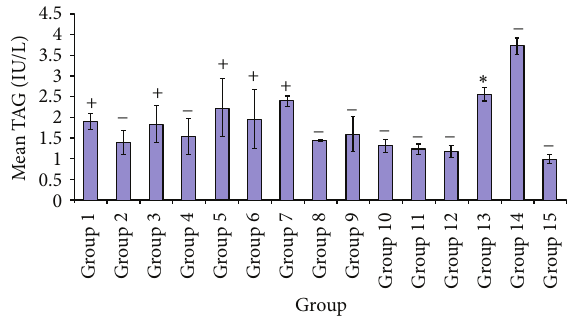
Figure 7: Comparative effects of some plants extracts on alanine aminotransferase (ALT) level.